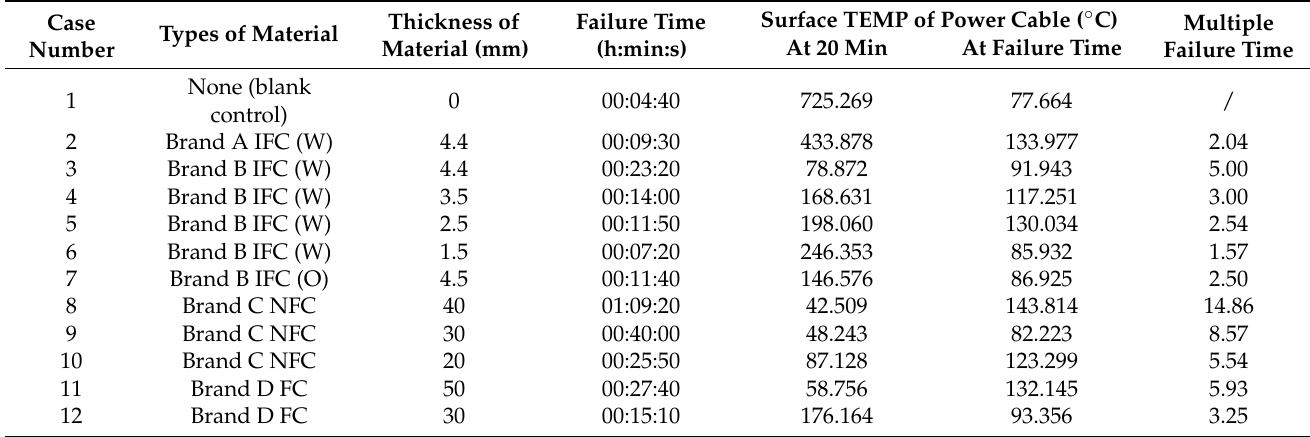
Table 4. Result statistics for 12 cases.